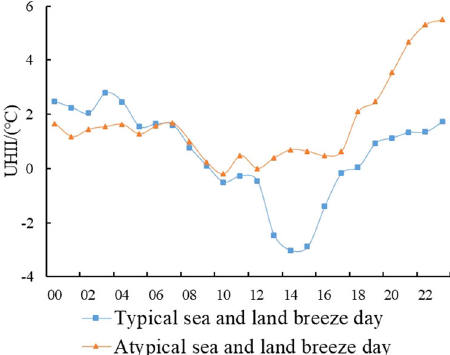
Fig. 5 Daily variation characteristics of heat island intensity between typical sea – land breeze day and atypical sea – land breeze day. 00-22 in the horizontal axis represents time